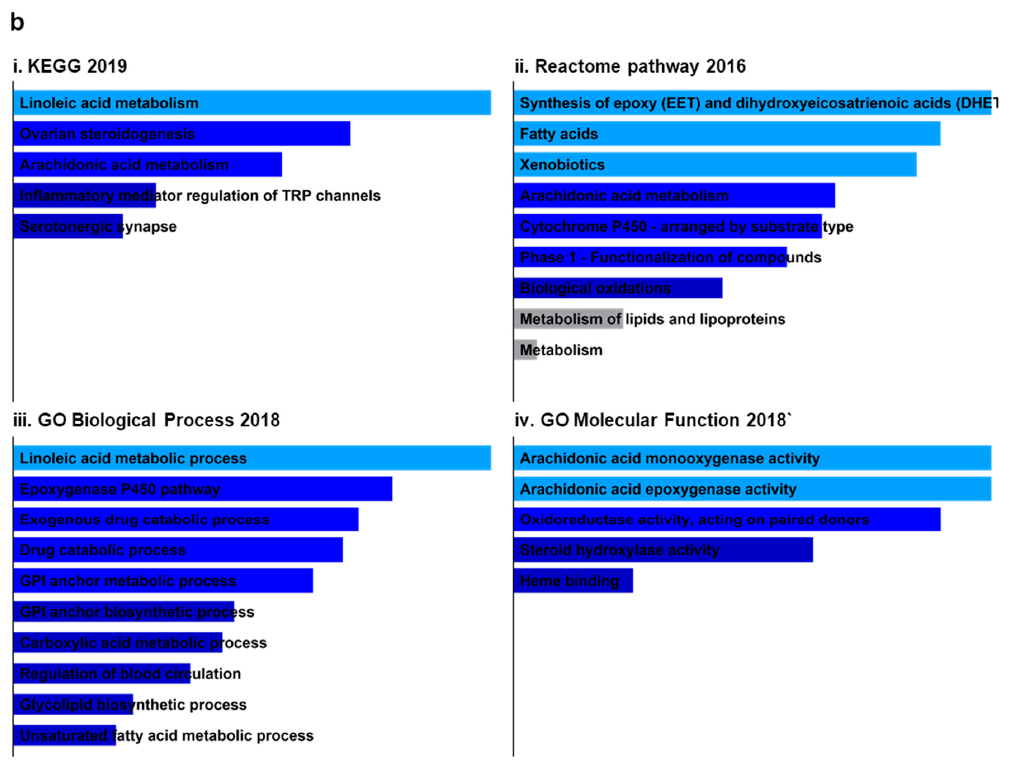
Figure 4. Putative pathways and Gene Ontology (GO) of common DEGs in IC/BPS. The bar graphs from the Enrichr platform obtained the Kyoto Encyclopedia of Genes and Genomes (KEGG), Reactome pathway, National Cancer Institute (NCI)-Nature Pathway, and Gene Ontology ( p -value ≤ 0.05, top 10 pathways of significance). There are red bars for upregulated genes ( a ) and blue bars for downregulated genes ( b ). Red bars indicate upregulated common DEG groups. Conversely, blue bars represent downregulated common DEG groups. The darker bar color indicates a less significant p - value.